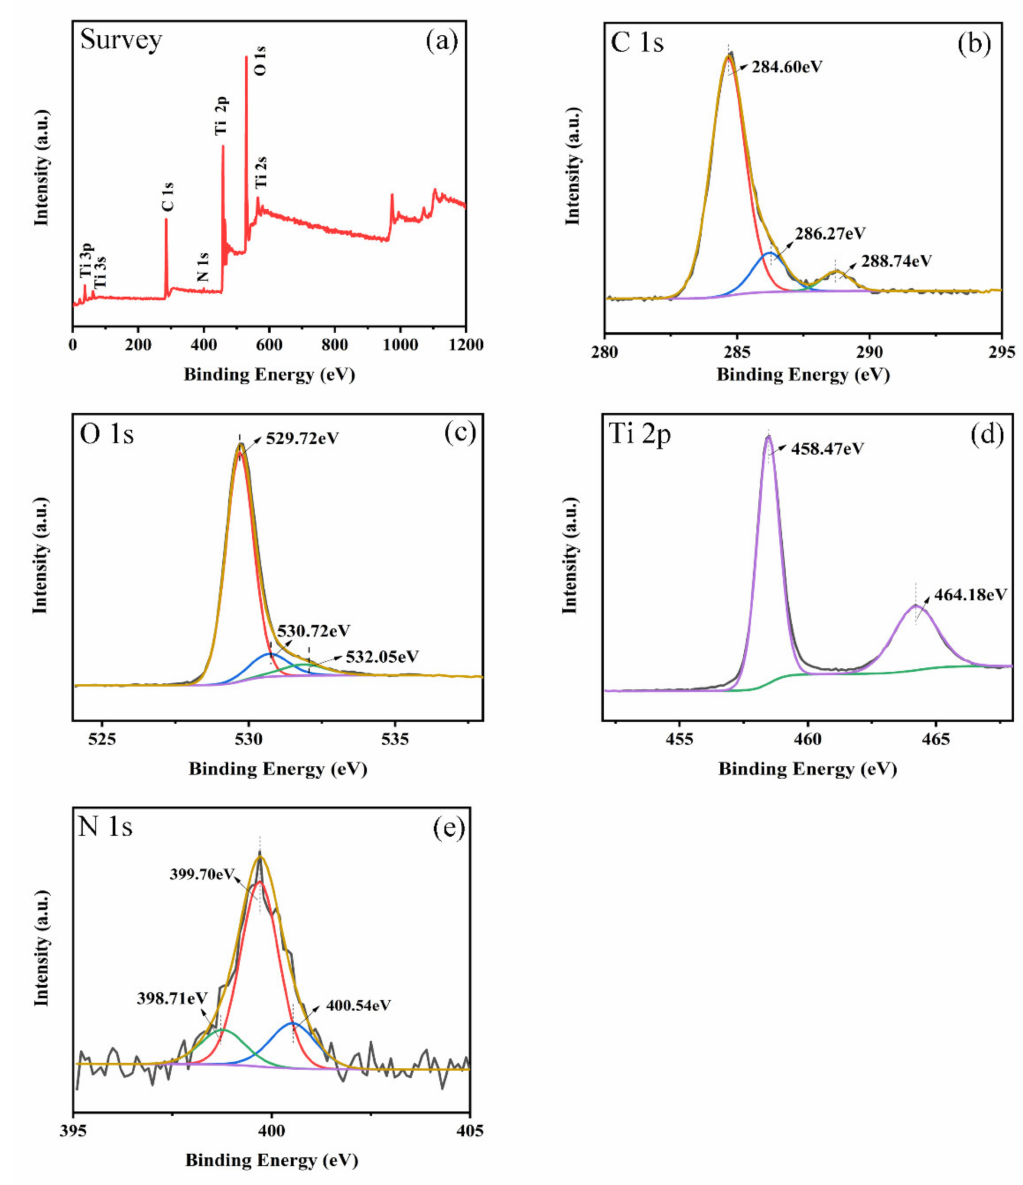
Figure 5. The high-resolution XPS spectra of the 40% g-C 3 N 4 /TiO 2 composite: survey ( a ), C 1s ( b ), O 1s ( c ), Ti 2p ( d ), and N 1s ( e